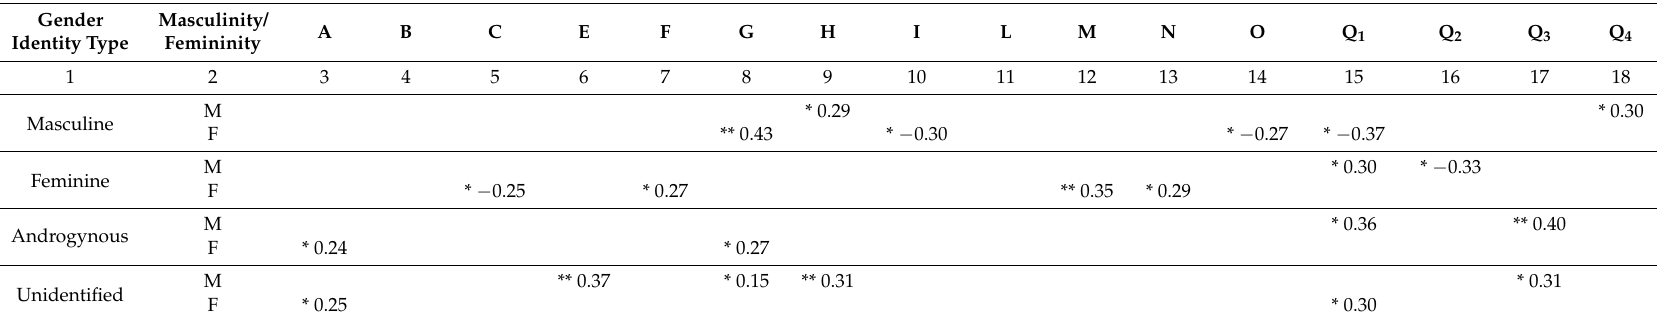
Table 2. Correlation dependencies of masculinity and femininity expressions with Raymond B. Cattell’s Sixteen Personality Factor Questionnaire among male teenagers. Gender Identity Type